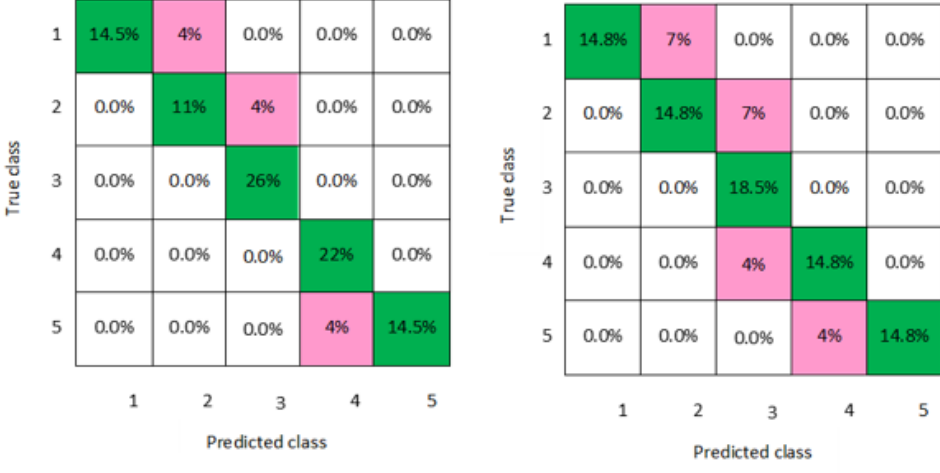
Figure 3. Linear SVM model confusion matrixes for men and women data, respectively.